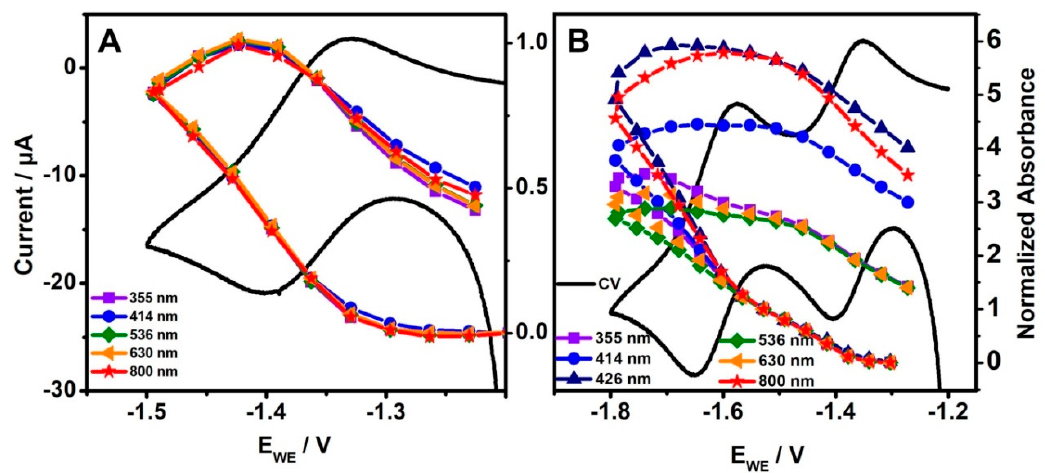
Figure 3. Dependence of the normalized absorbance intensity (normalized to the first reduction) at selected wavelengths on the applied electrode potential for the ( A ) first and the ( B ) second reduction wave.